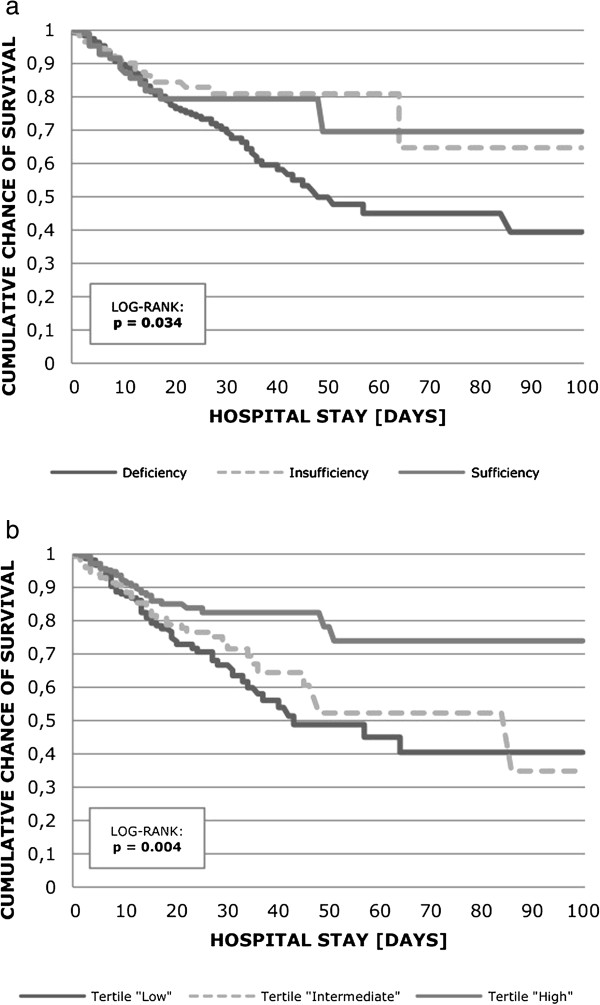
Unadjusted Kaplan-Meier plot for hospital survival stratified by definition of vitamin D deficiency (a) and month-specific vitamin D tertiles (b). Using the log-rank test, hospital mortality was significantly different between vitamin D sufficiency, insufficiency and deficiency (P = 0.034) and vitamin D tertiles (P = 0.004).